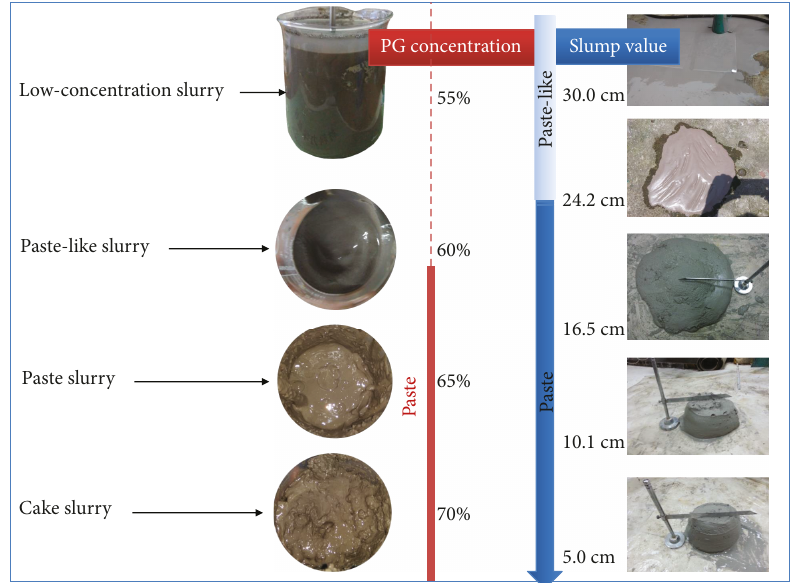
Figure 17: Di ff erent types of paste and paste-like